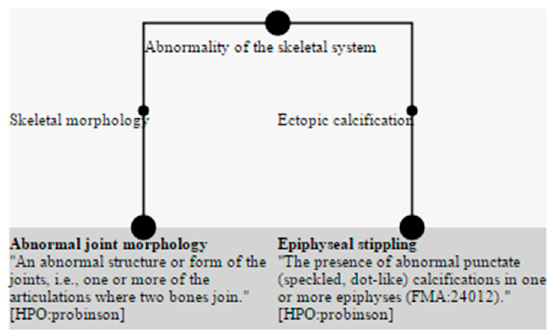
Figure 29. Route between of “Abnormal Joint Morphology” and “Abnormal Epiphyseal Stip- pling”.